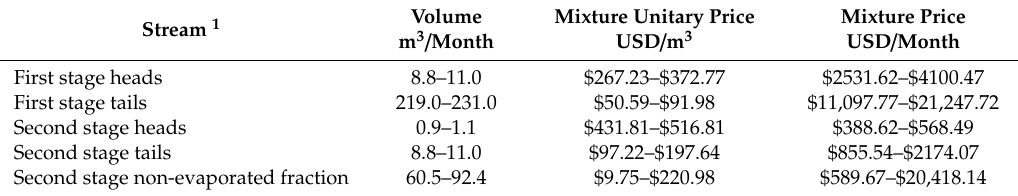
Table 6. Approximate volume proportion of residual streams studied and mixture price for a